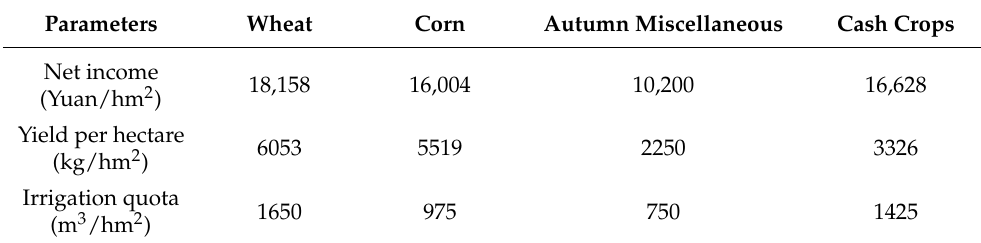
Table 1. Parameters of the